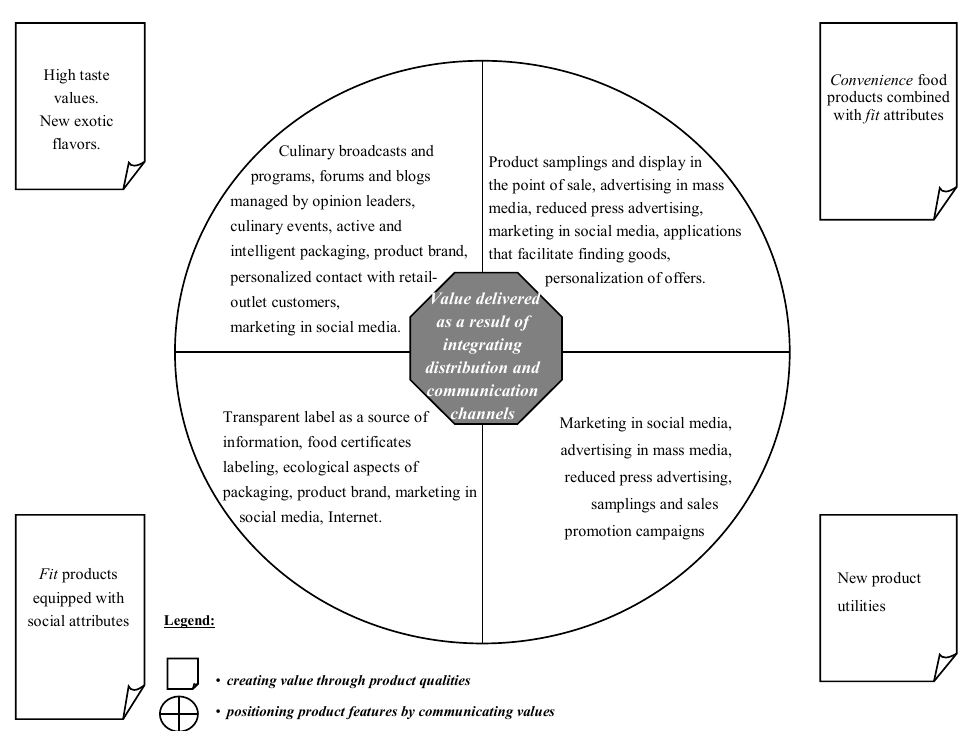
Figure 4. Examples of marketing activities targeting millennial consumers in the food market. Source: based on own research.